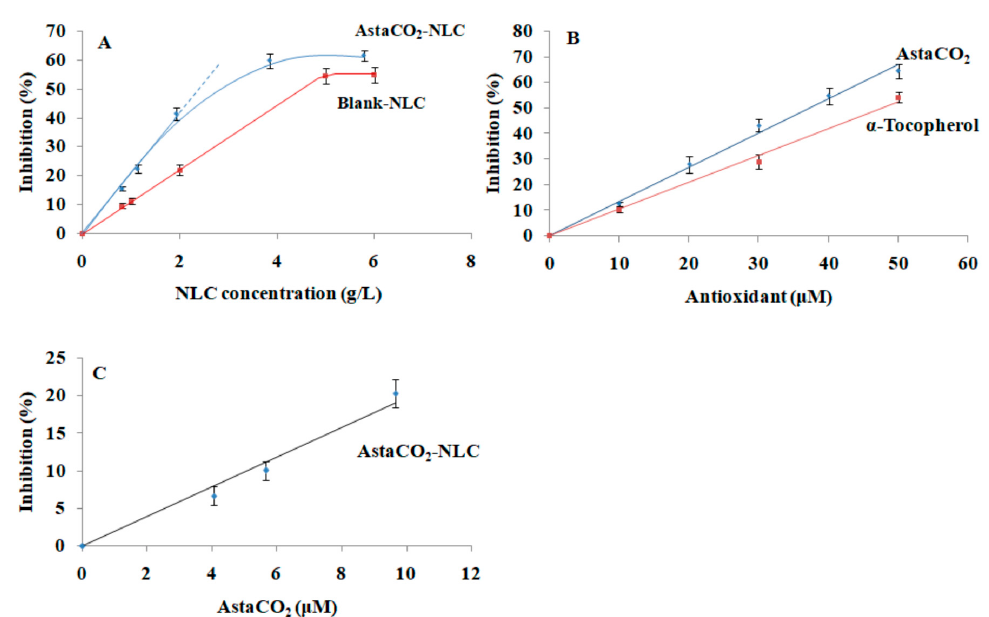
Figure 4. Decrease of the absorbance of 2.2 ′ -azino-bis(3-ethylbenzothiazoline-6-sulphonic acid) diammonium salt radical cation (ABTS • + ), measured as inhibition, as a function of the concentration of AstaCO 2 -NLC and Blank-NLC, expressed as NLC concentration in (g/L) ( A ); AstaCO 2 and α - tocopherol, expressed as antioxidant concentration in (µM) ( B ); and AstaCO 2 -NLC, expressed as astaxanthin concentration in (µM) ( C ).